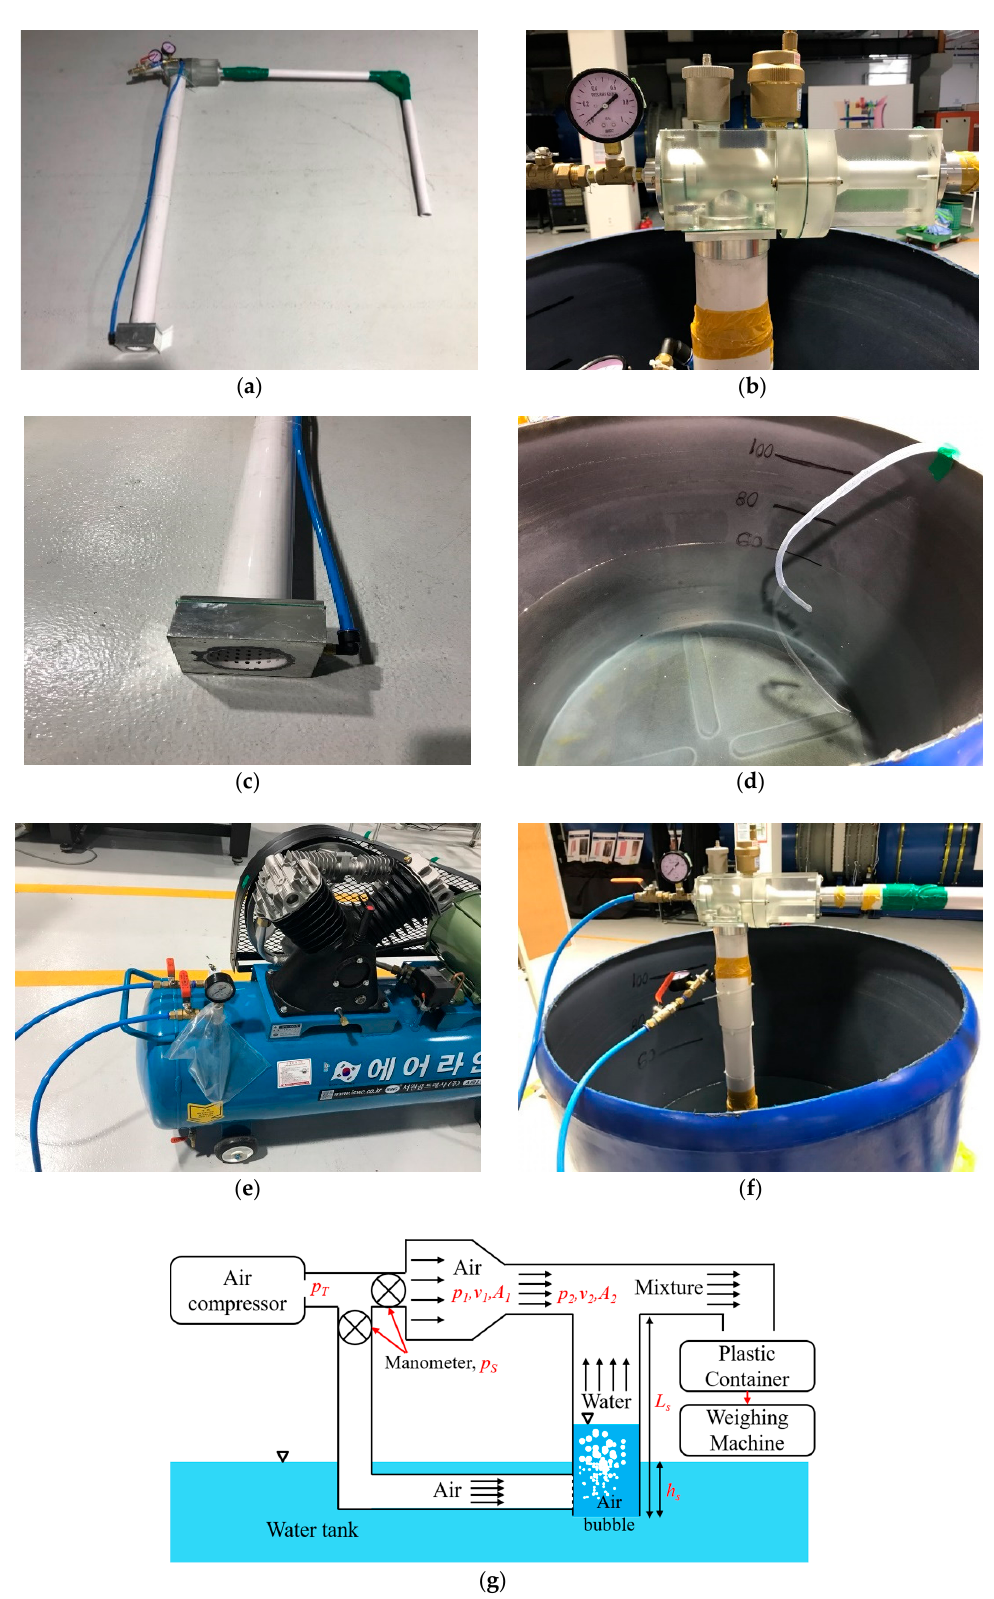
Figure 7. Experiment using the prototype hybrid pump: ( a ) prototype of hybrid pump; ( b ) jet pump part; ( c ) airlift pump part; ( d ) water tank; ( e ) air compressor; ( f ) prototype hybrid pump connected with an air compressor in water tank; and ( g ) schematics of an experimental setup.